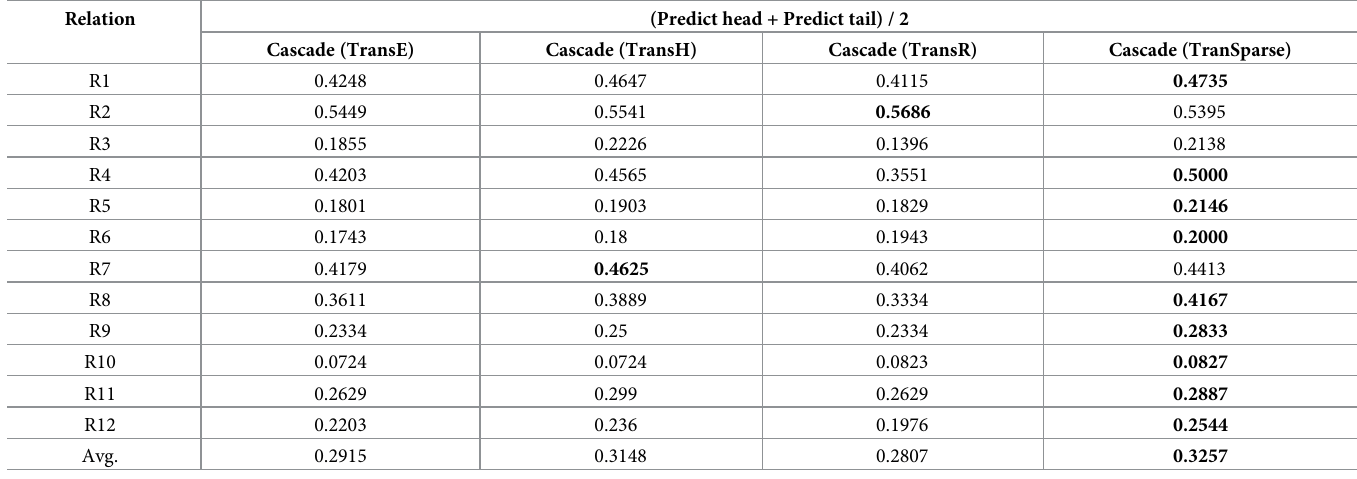
Table 7. Entity prediction based on settings of different knowledge embedding algorithms (hits@10).